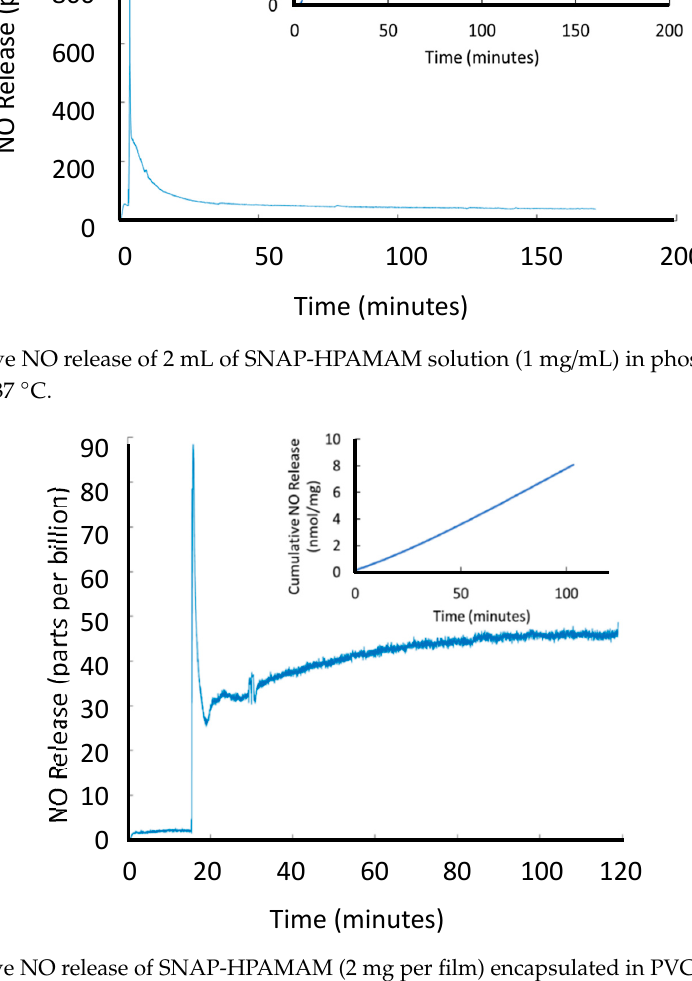
Figure 4. Passive NO release of SNAP-HPAMAM (2 mg per film) encapsulated in PVC in 2 mL of PBS at 37 °C.